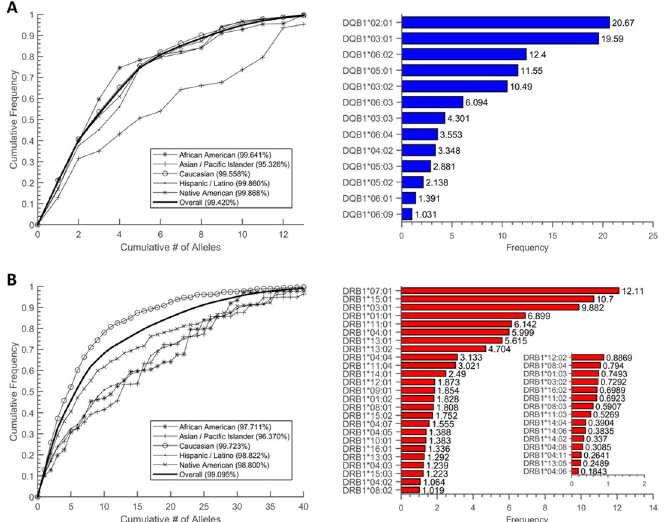
Fig 2. HLA population frequencies. (A) HLA-DQB1 and (B) HLA-DRB1 cumulative (line graphs with race/ethnicity data) and individual allele (bar graphs) population frequency information is displayed here. Cumulative frequency plots display summed frequencies of sequentially ordered HLA beta alleles (greatest to smallest for total population) vs. the number of alleles included in the sum. Individual allele plots display HLA alleles vs. their respective overall population